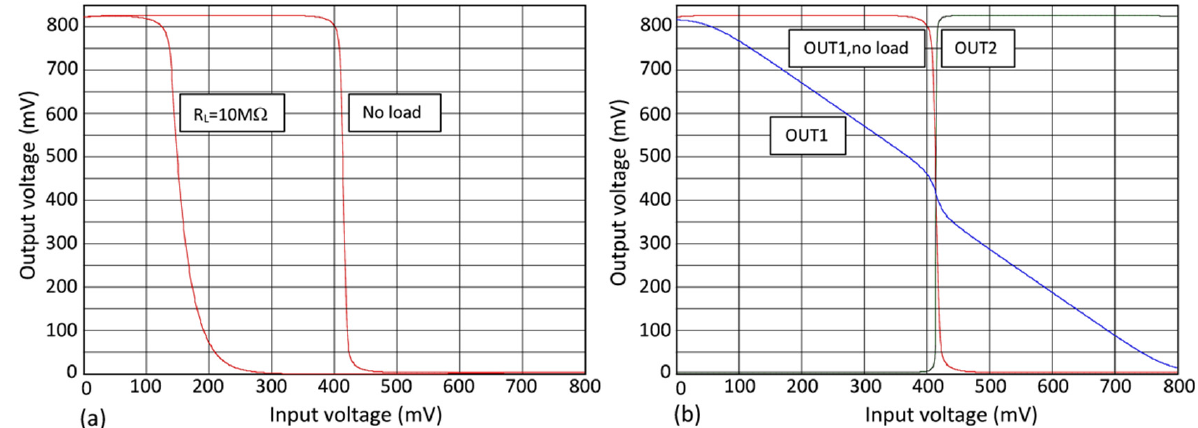
Figure 17. Simulated transfer characteristics of inverter with resistive load ( a ) and inverter with nonlinear load (input of another inverter—( b )). V CC = 1 V, R = 10 k Ω , temperature 300 K.